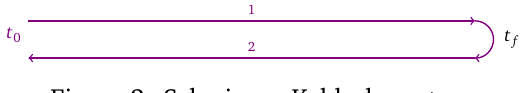
Figure 2: Schwinger-Keldysh